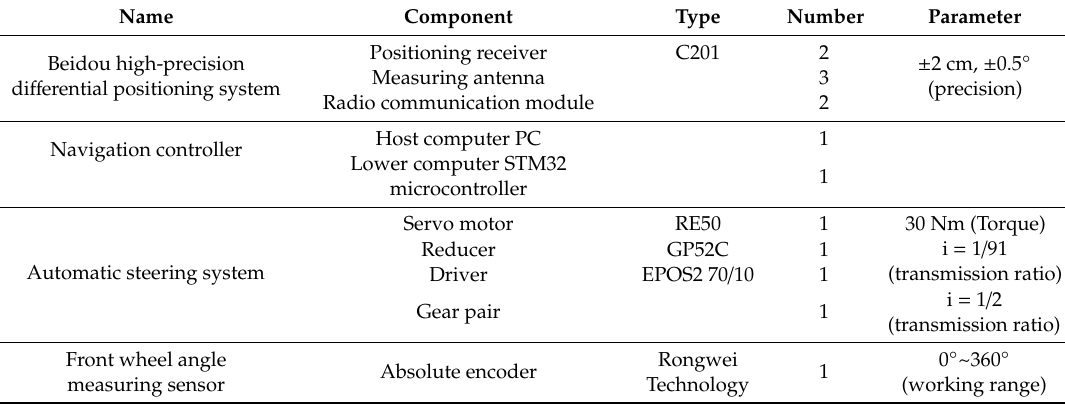
Figure 2. Actuator of the automatic steering system. ( 1 ) Steering wheel of the transplanter; ( 2 ) steering axle gear; ( 3 ) output axle gear; ( 4 ) reducer; ( 5 ) servo motor; ( 6 ) motor bracket; ( 7 ) absolute encoder. Table 1. Parameters of the navigation hardware for the experimental platform.